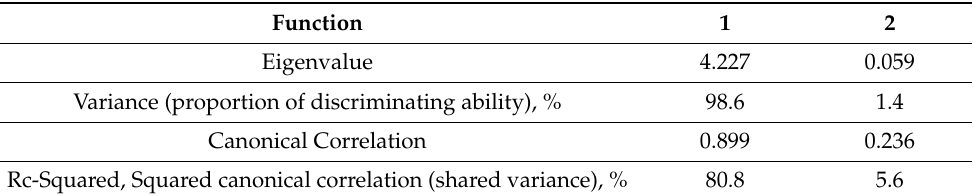
Table 9. Canonical variate pairs (discriminant functions) found in canonical discriminant analysis for genetic diversity